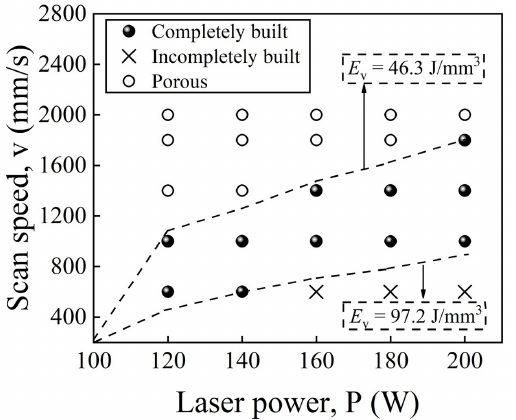
Figure 8. Forming quality of the samples under different laser conditions.